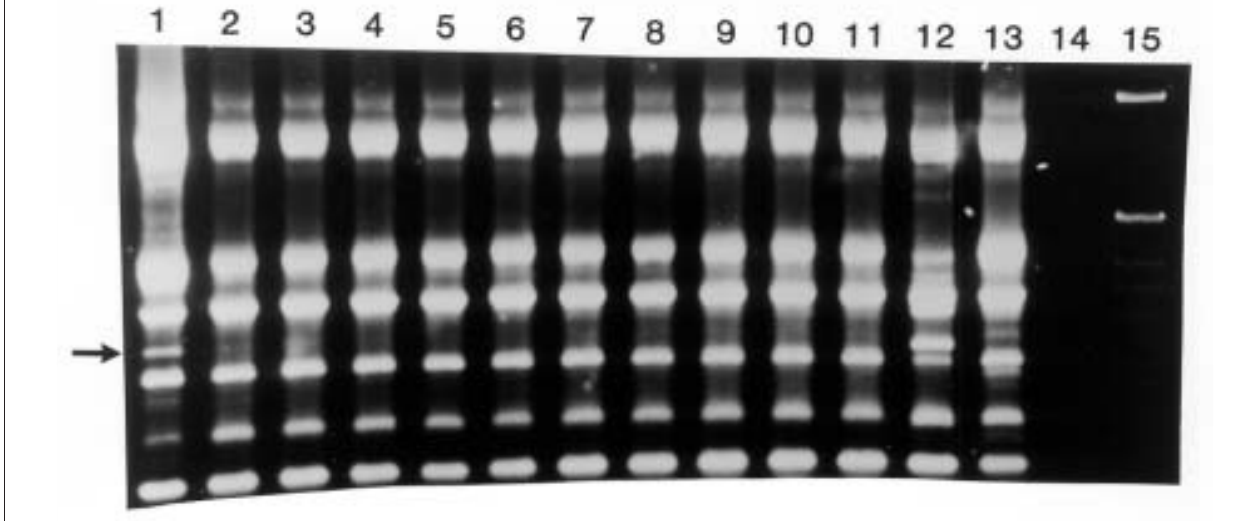
Figure 2) DNA fingerprint profile of Salmonella tilene isolates generated to conserved regions of Escherichia coli 16/23S rRNA by polymerase chain reaction. Lanes 1 to 11: 22/77 (Washington State isolate), 44950, 44951, 44952, 44209, 93116, 93120, 97315, E2212, R763, R849 (refer to Table 1 fordescriptionofstrains).Lanes12,13,14and15are Salmonellajohannesburg , Salmonellanewport